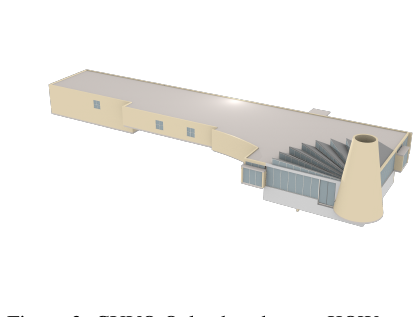
Figure 3. CUVO Ockenburghstraat KOW.